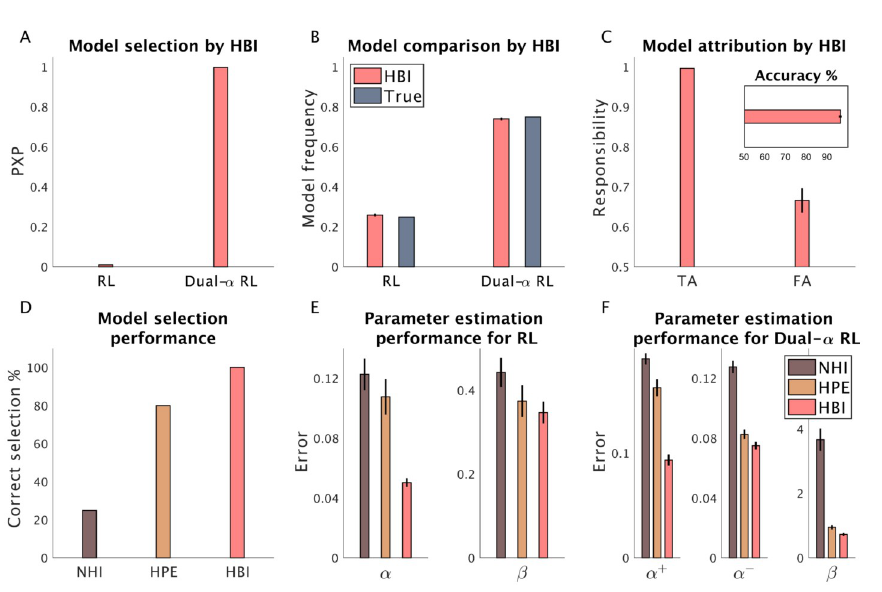
Fig 3. Performance of the HBI in a synthetic dataset including models with the different number of parameters. 10 and 30 artificial subjects were generated according to the RL and dual- α RL models, respectively. A) Model selection by HBI using protected exceedance probabilities (PXP); B) Model frequencies estimated by the HBI. C) Model attribution at the individual level by the HBI. Responsibility estimates are plotted for true attributions (TA) and for false attributions (FA). The HBI shows lower levels of responsibility for FA. Inset: percentage of correct assignment of the model by the HBI at the individual level. D) Model selection performance of NHI, HPE, and HBI; E, F) Error in estimating individual parameters of the RL (E) and the dual- α RL model (F). The estimation error is defined as the absolute difference between estimated parameters and the true parameters. In all plots, error-bars are standard errors of the mean obtained across 20